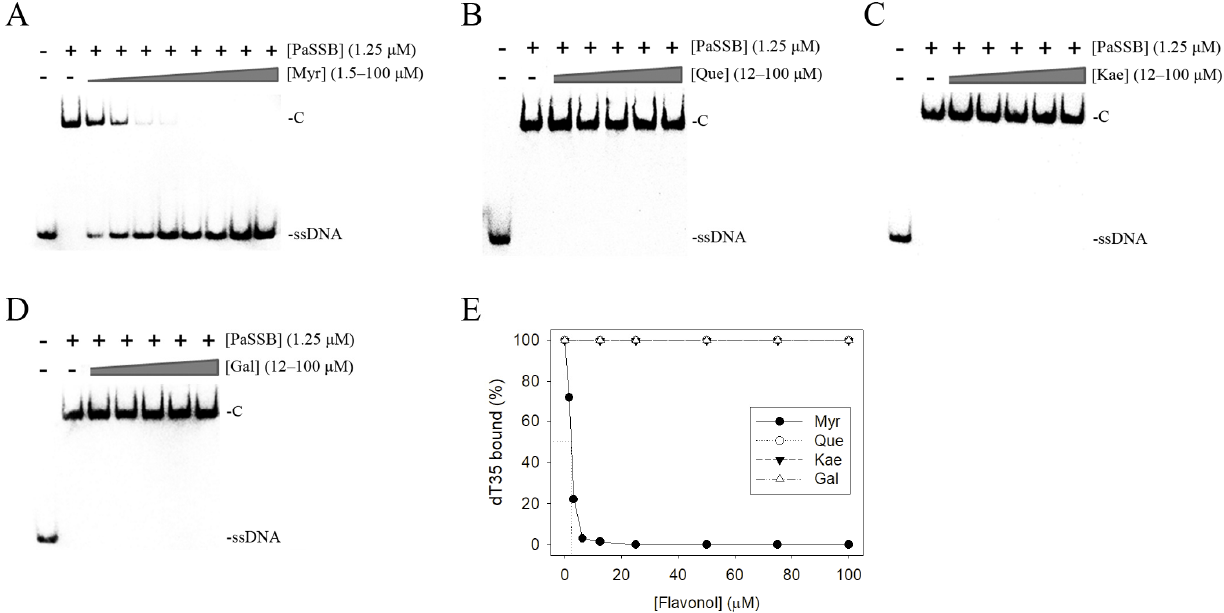
Figure 3 . Inhibition of the ssDNA binding activity of PaSSB by flavonols. PaSSB (1.25 μ M) was in ‐ cubated with ( A ) myricetin, ( B ) quercetin, ( C ) kaempferol, and ( D ) galangin. These flavonols were dissolved in 10% dimethyl sulfoxide (DMSO). Quercetin, kaempferol, and galangin did not inhibit the binding of PaSSB to dT35. ( E ) An IC 50 determination for PaSSB. PaSSB (1.25 μ M) was incubated with myricetin (0, 1.5, 3.1, 6.3, 12.5, 25, 50, 75, and 100 μ M), quercetin (12–100 μ M), kaempferol (12– 100 μ M), and galangin (12–100 μ M). Myricetin could inhibit the ssDNA binding activity of PaSSB with an IC 50 of 2.8 ± 0.4 μ